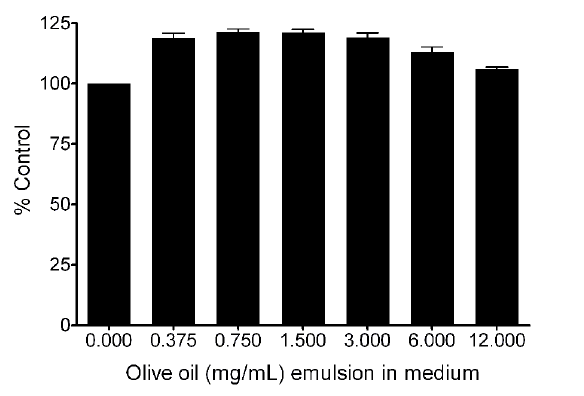
Figure S4. Effect of olive oil nanoemulsion on macrophage viability after 24 h incubation. CellTiter-Glo ® luminescent (Promega) cell viability assay was performed according to manufacturer instructions. Error bars represent standard deviation of at least three independent samples.